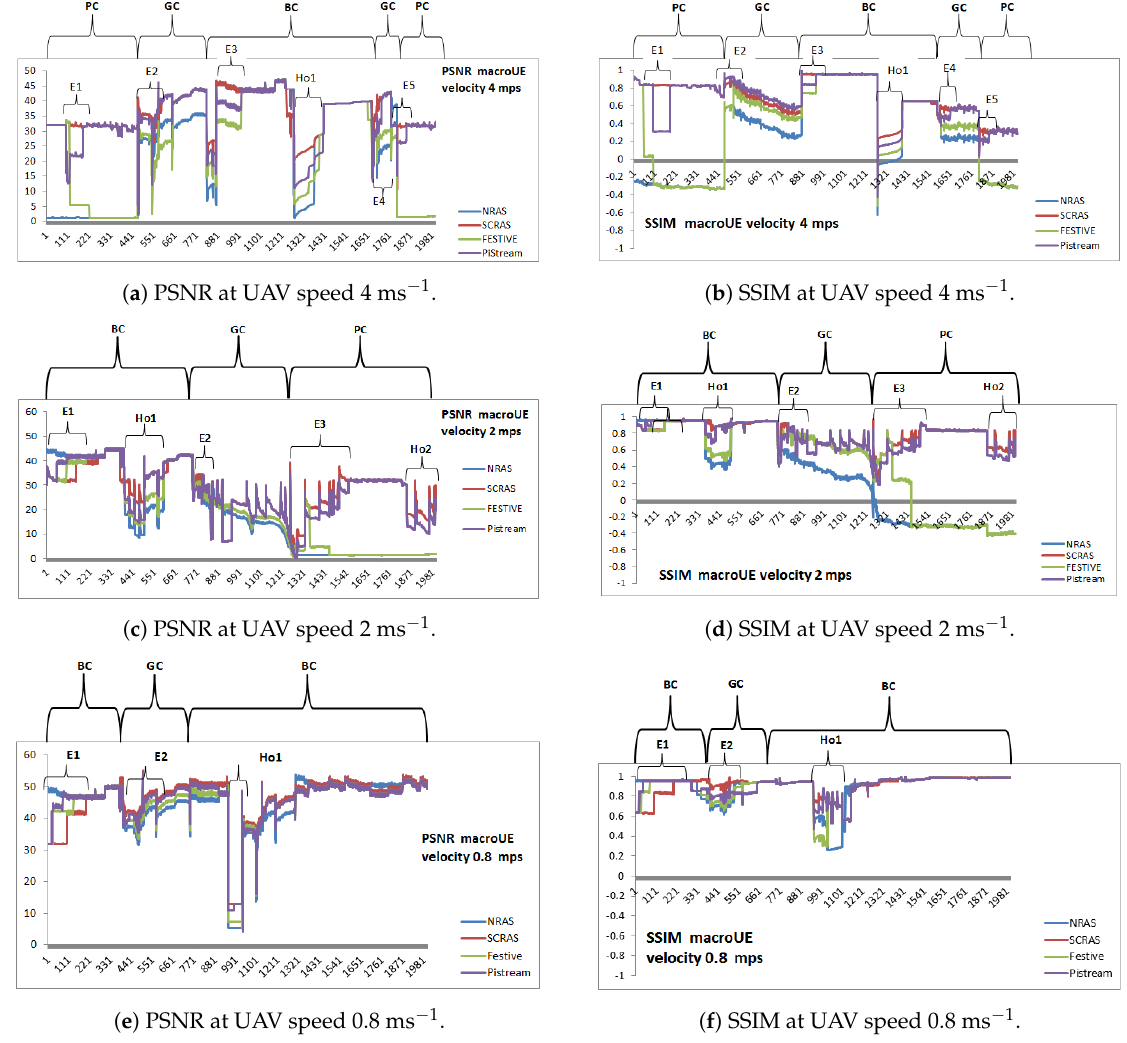
Figure 7. Varying velocity of unmanned aerial vehicles